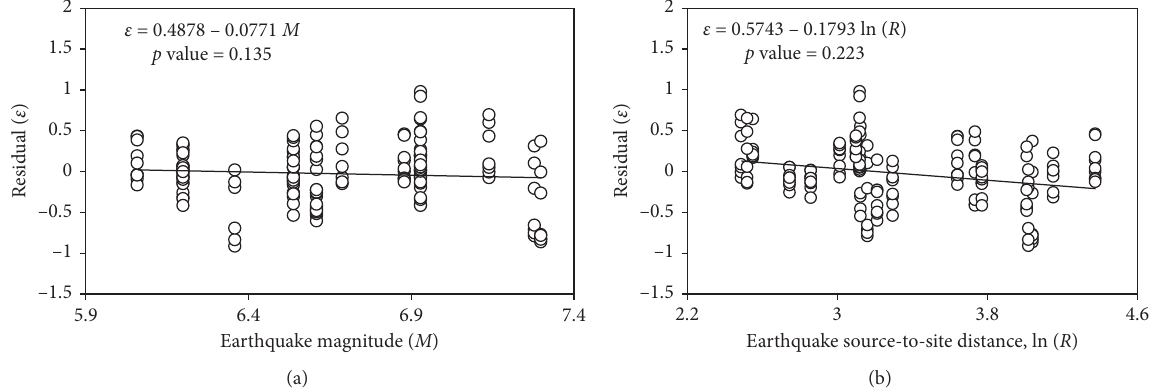
Figure 8: Sufficiency of S